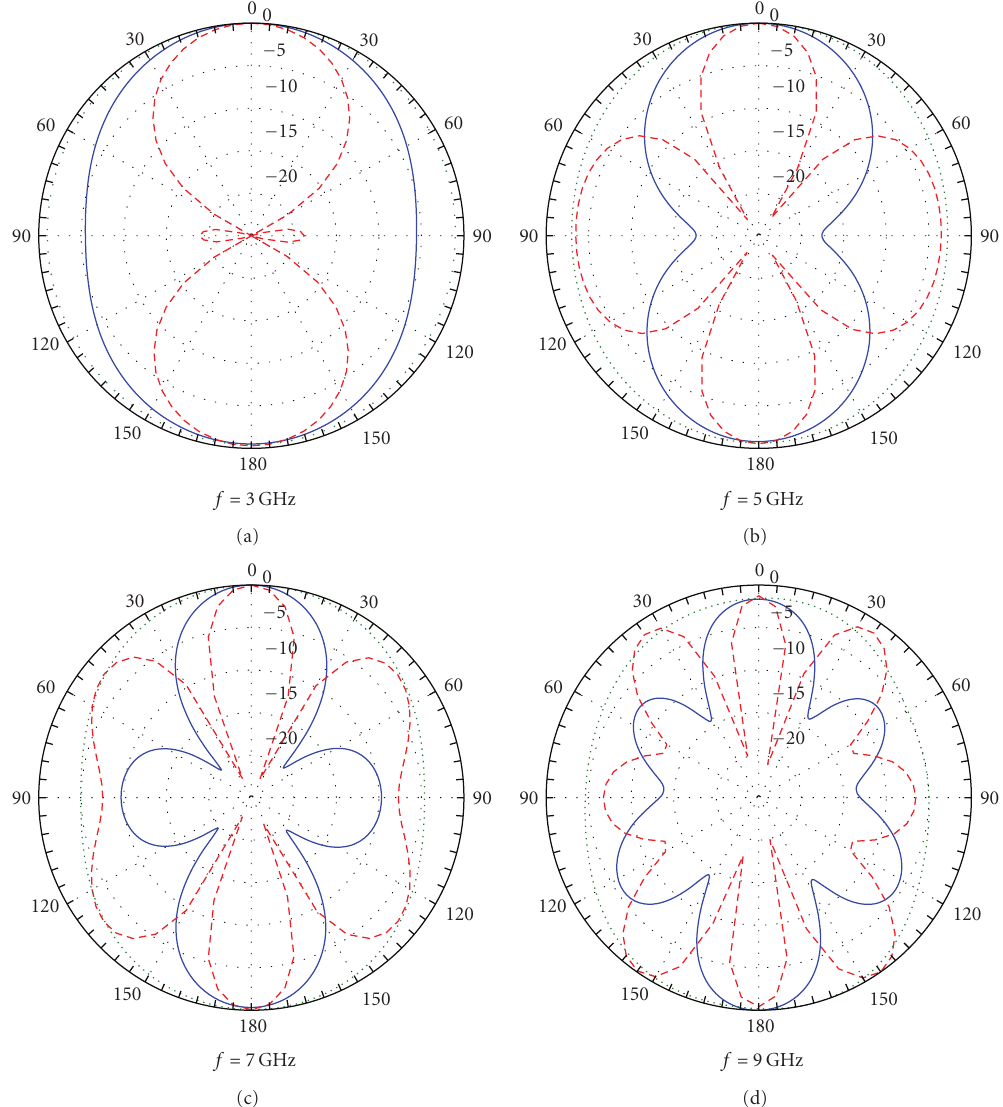
Figure 10: Simulated H -plane ( YZ -plane) radiation patterns for the two-element UWB array at di ff erent element spacing values d = 28 mm (solid line) and d = 54 mm (dashed line) compared to a single antenna element (dotted